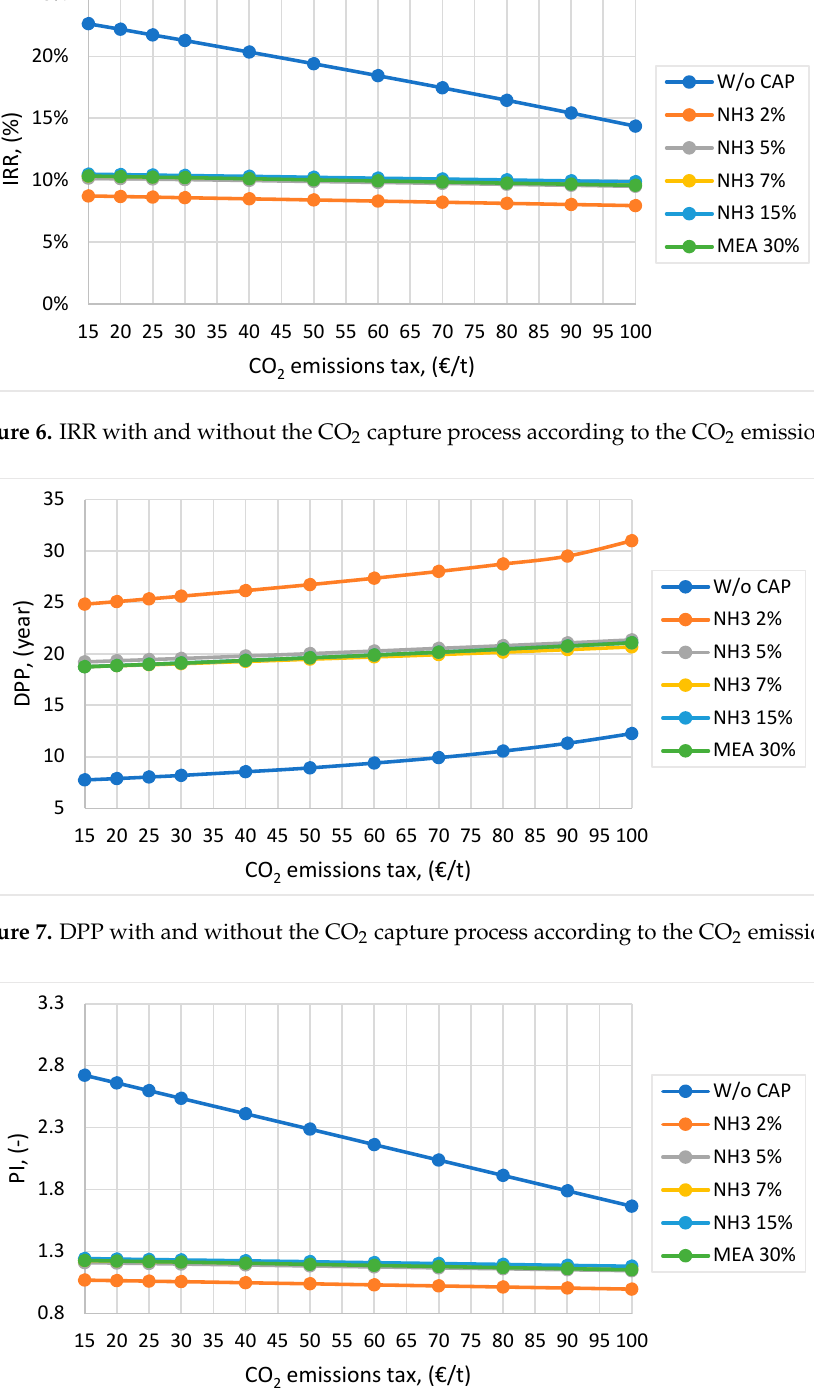
Figure 8. PI with and without the CO 2 capture process according to the CO 2 emissions tax.